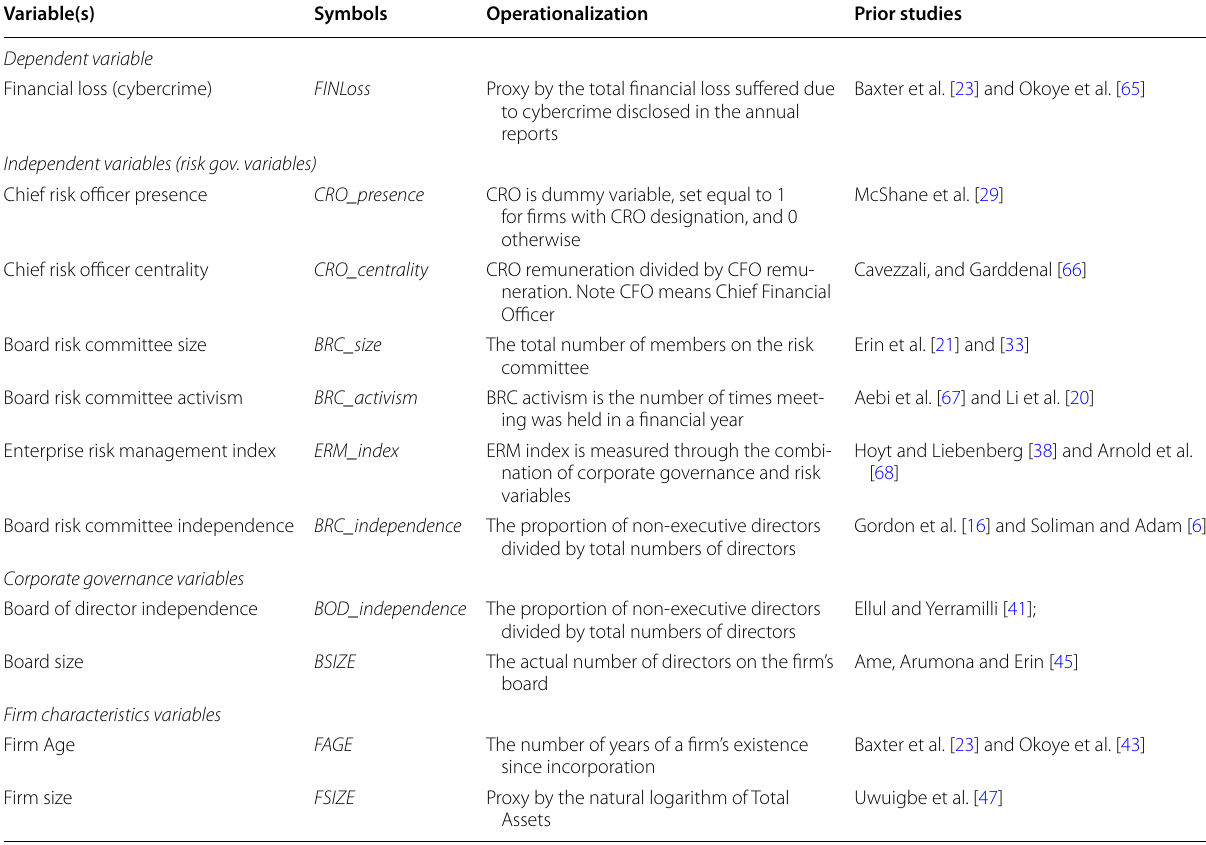
Table 1 Measurement and operationalization of variables. Source : Developed by Authors Variable(s) Symbols Operationalization Prior studies Dependent variable Financial loss (cybercrime) FINLoss Proxy by the total financial loss suffered due to cybercrime disclosed in the annual reports Independent variables (risk gov.